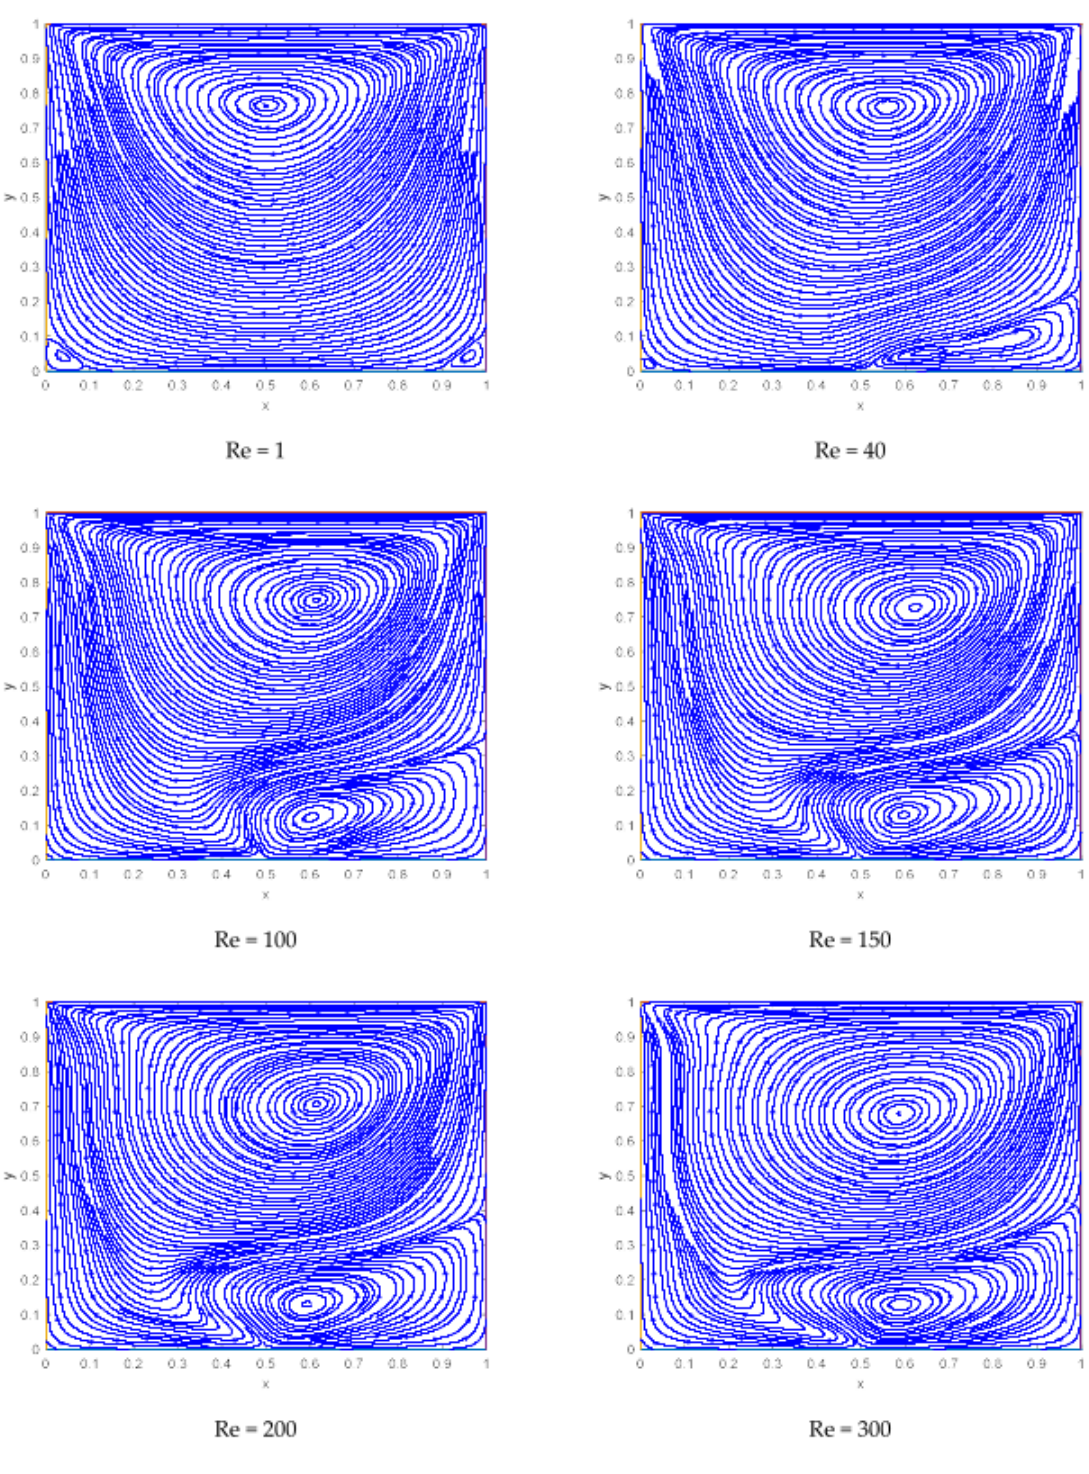
Figure 9. Representation of streamlines for various values of Reynolds